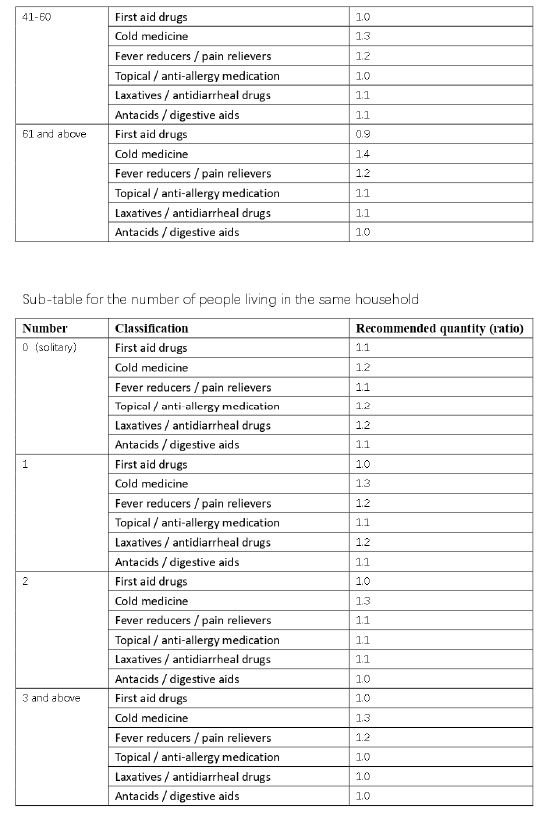
Figure 13. The initial version of the system.